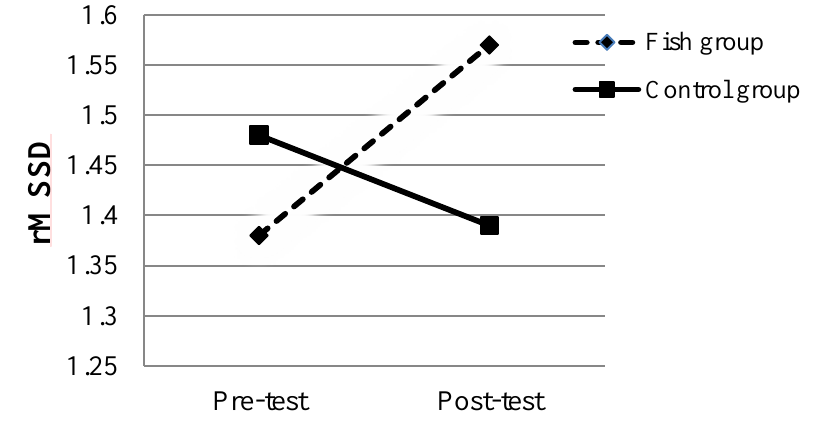
Figure 2. The root mean square of successive differences (rMSSD) for both groups during pre- and post-test. The standard deviations are presented in Table